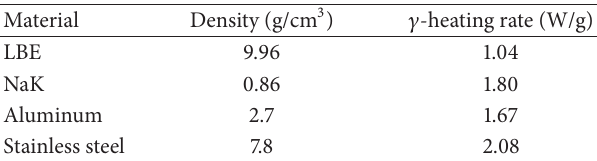
Table 2: Heating rate at OR5.